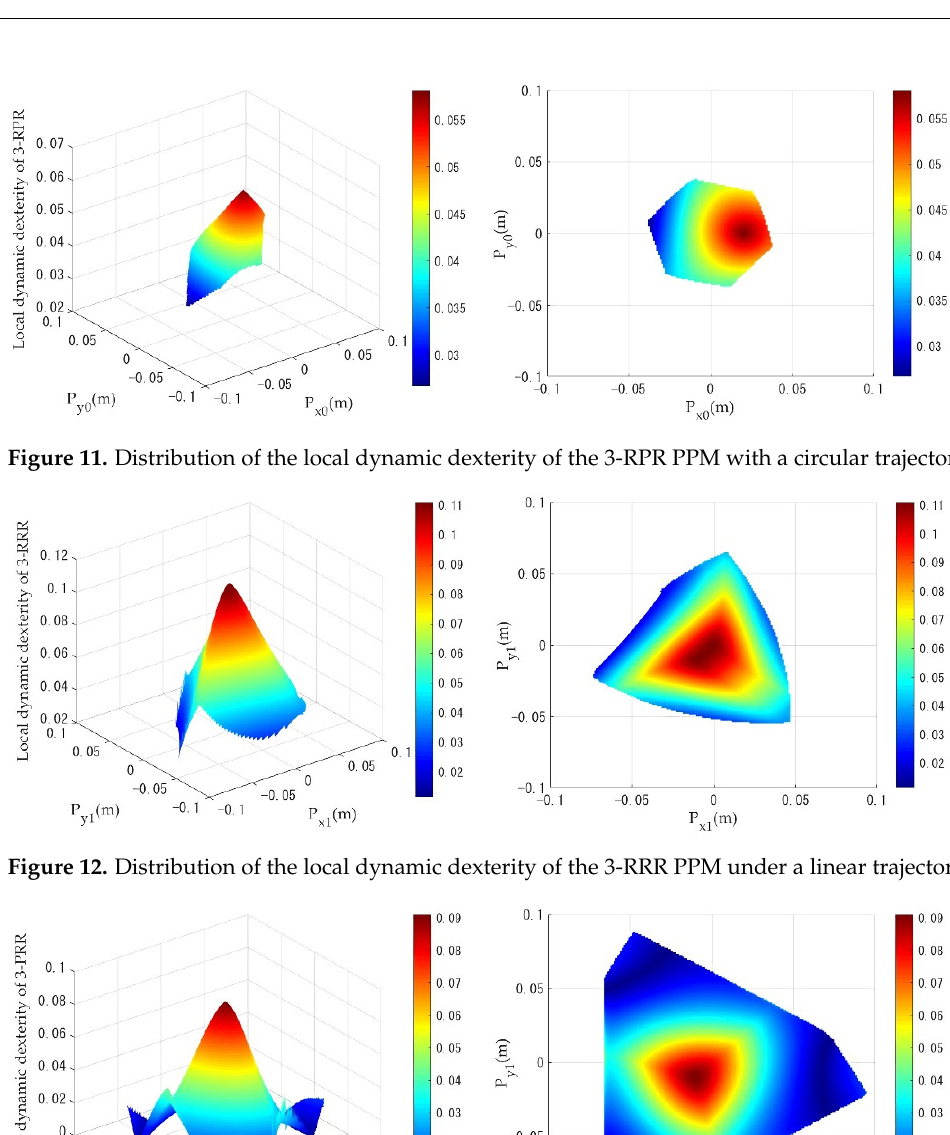
Figure 10. Distribution of the local dynamic dexterity of the 3-PRR PPM with a circular trajectory.